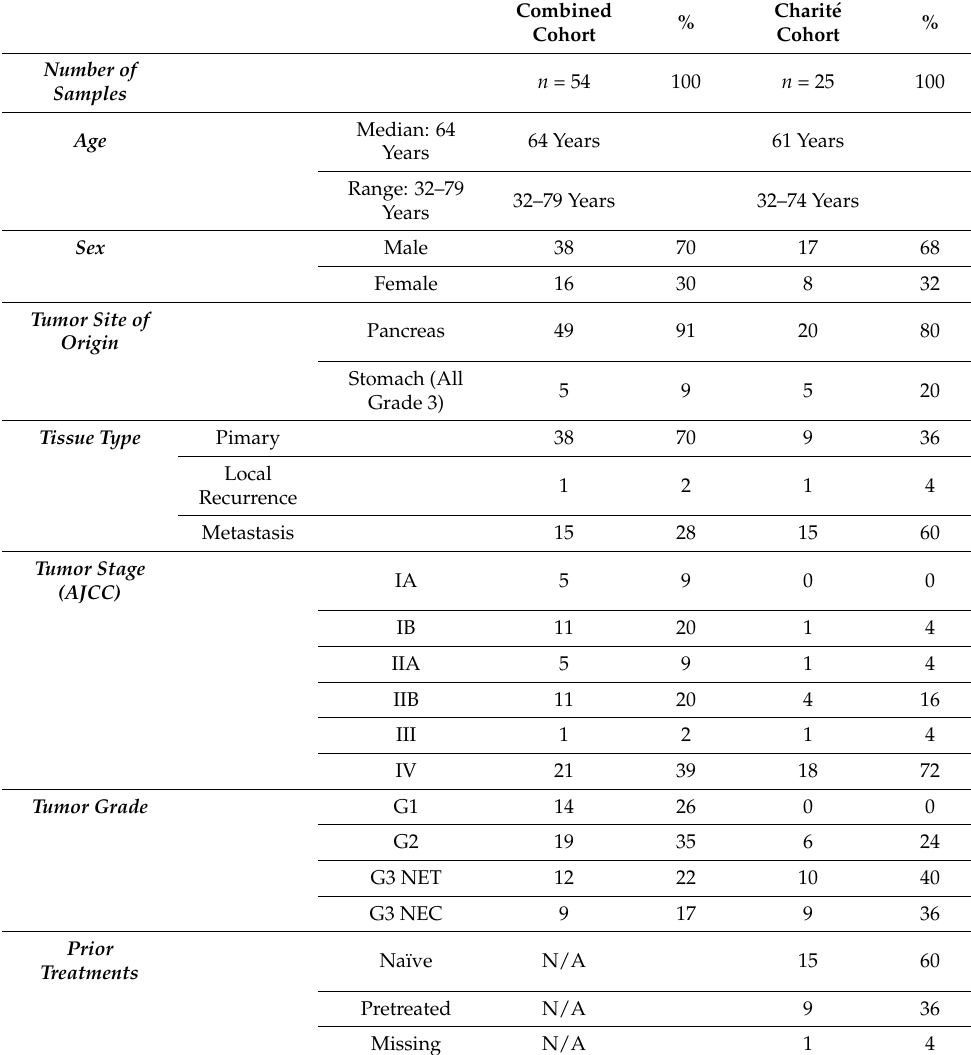
Table 2. Sample characteristics of the NEN transcriptome cohorts. Description of the samples used for tissue-based analyses of mRNA expression. The combined cohort was used for the correlation of FLT3LG mRNA expression with tumor grade and immune cell markers or signatures. All other tissue-based analyses used data from the Charit é subset of samples, thereby minimizing involuntary bias due to different data